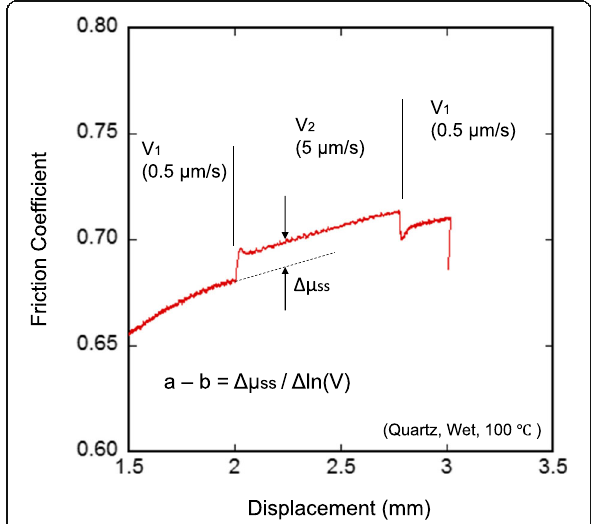
Fig. 2 Enlarged example of a friction curve showing the step changes of slip velocity. The velocity dependence of steady-state friction ( a – b ), as determined from Eq. (2), is represented by the difference between the parallel steady-state trend lines immediately before and after velocity step changes. In these analyses, we used long trend of the friction curve, not only the portion immediately before and after the step